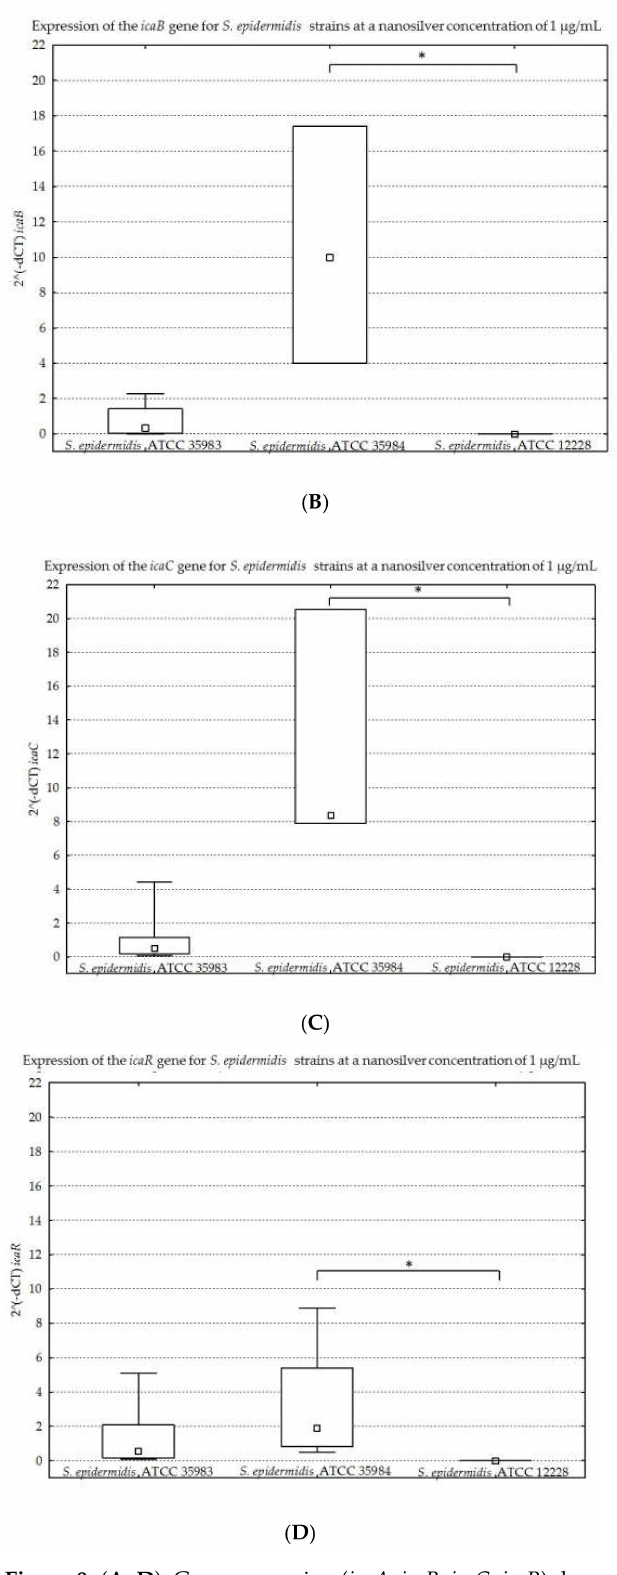
Figure 9. ( A – D ). Gene expression ( icaA , icaB , icaC , icaR ) depending on the strain of S. epidermidis at a nanosilver concentration of 1 µ g/mL, presented as medians and quartiles (Q1 and Q3). Statistical significance: * p <